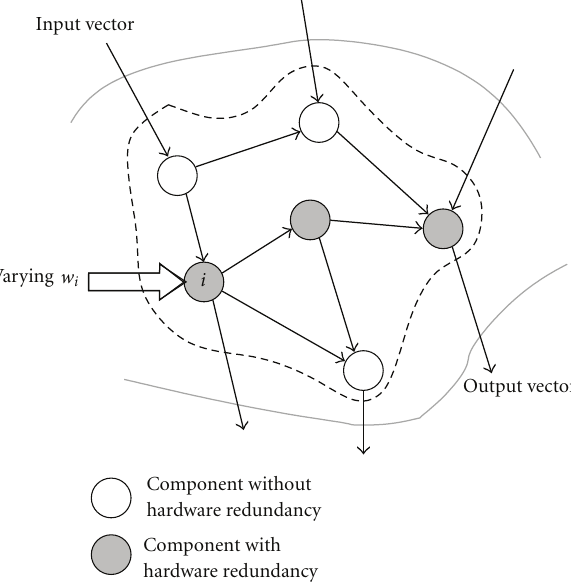
Figure 5: Conceptual diagram of sensitivity and criticality